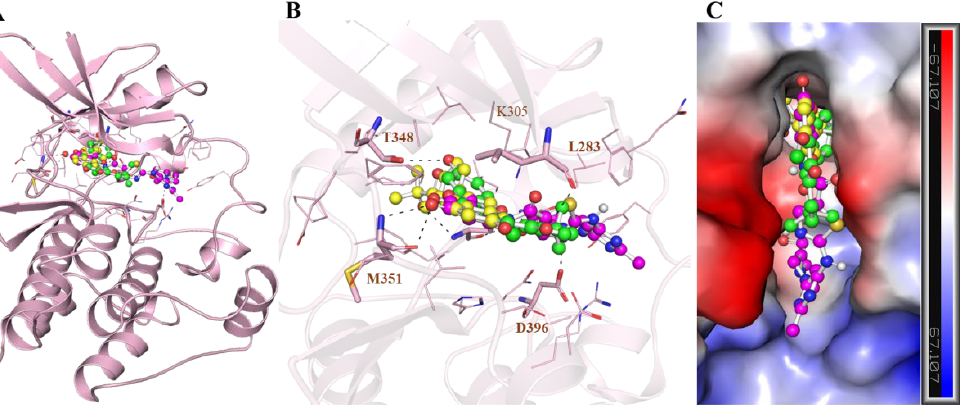
Figure 1. Molecular interactions of ( A ) YES1 with Glabrene (green), LIC (yellow), and Dasatinib (magenta) ( B ) Cartoon illustration of protein–ligand interactions. ( C ) Electrostatic potential surface view of YES1 bound with the selected compounds.